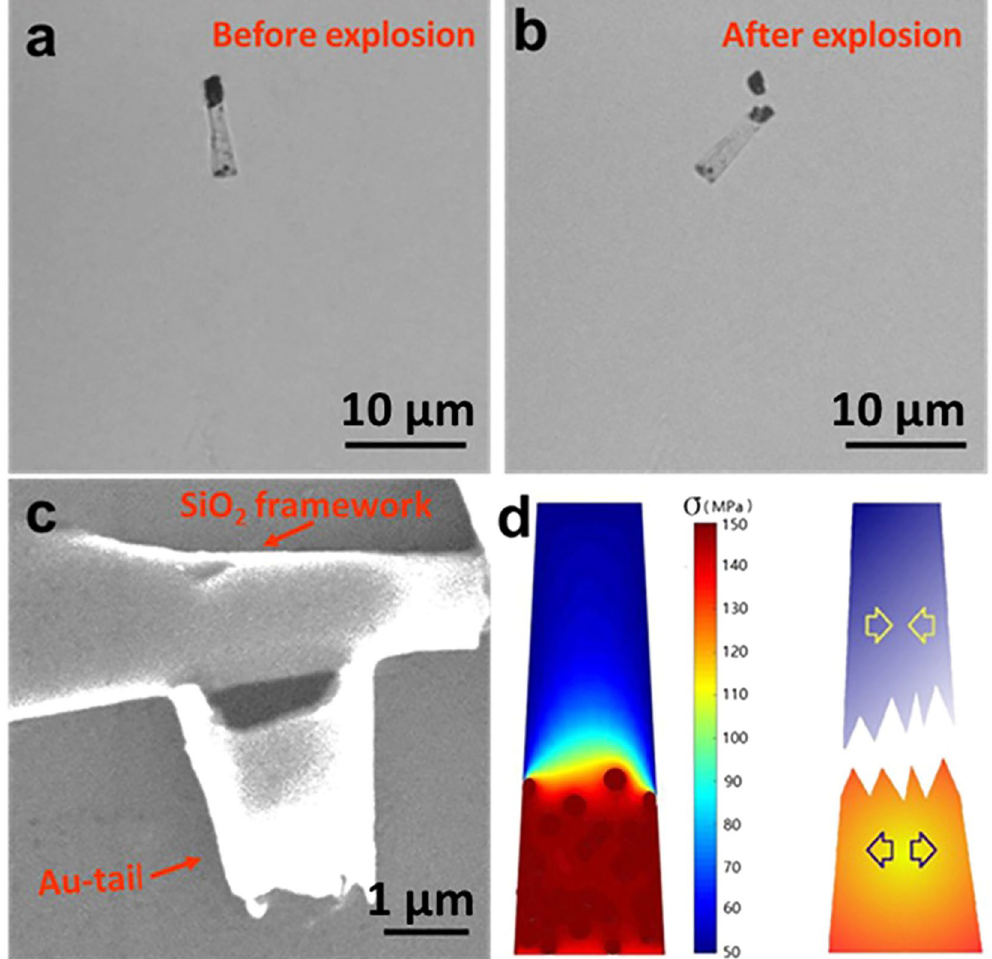
Figure 6. Time-Lapsed Images from Supplymentary Video 5 of A Torpedo Motor. ( a ) Au-tailed torpedobefore explosion. ( b ) Au-tailed torpedobefore explosion. ( c ) The SEM image of a torpedo after explosion. ( d ) Theoretical simulation of the NIR-triggered explosion of torpedo. The thermal stress distribution for the Au- tailed torpedo (left); Schematic effect of thermal stress: The tubular part with high temperature (the orange part) expands, the cold tubular part contracts (the blue